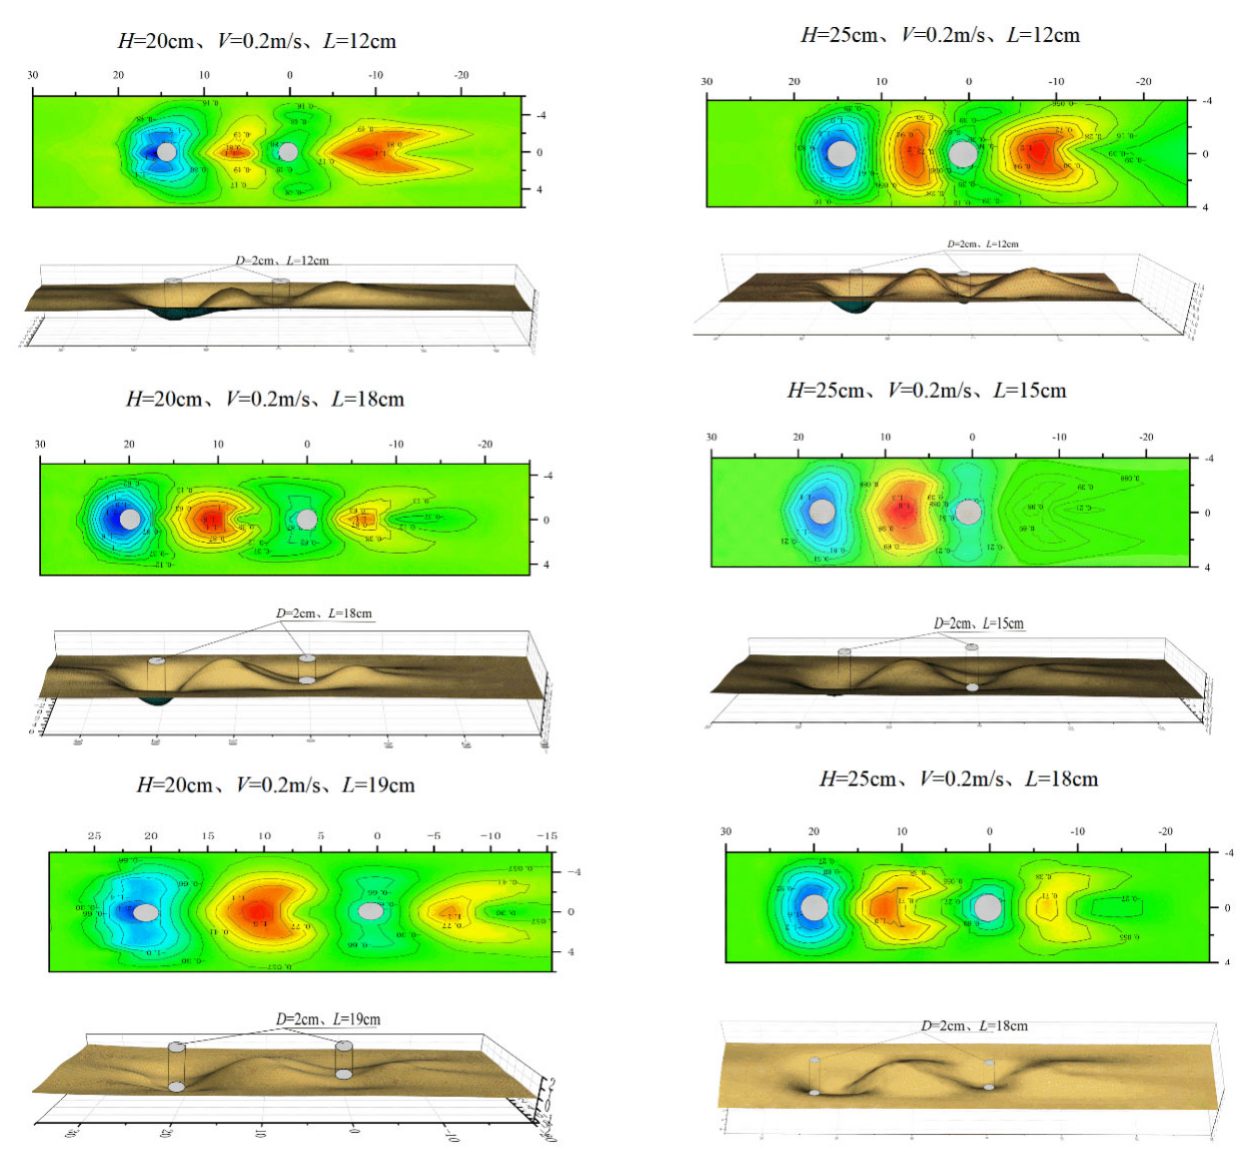
Figure 9. Pier scour contour diagrams for different pier spacing distances.